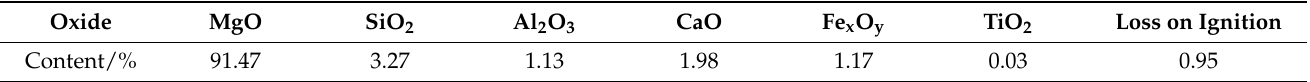
Table 1. Main chemical composition of magnesium oxide